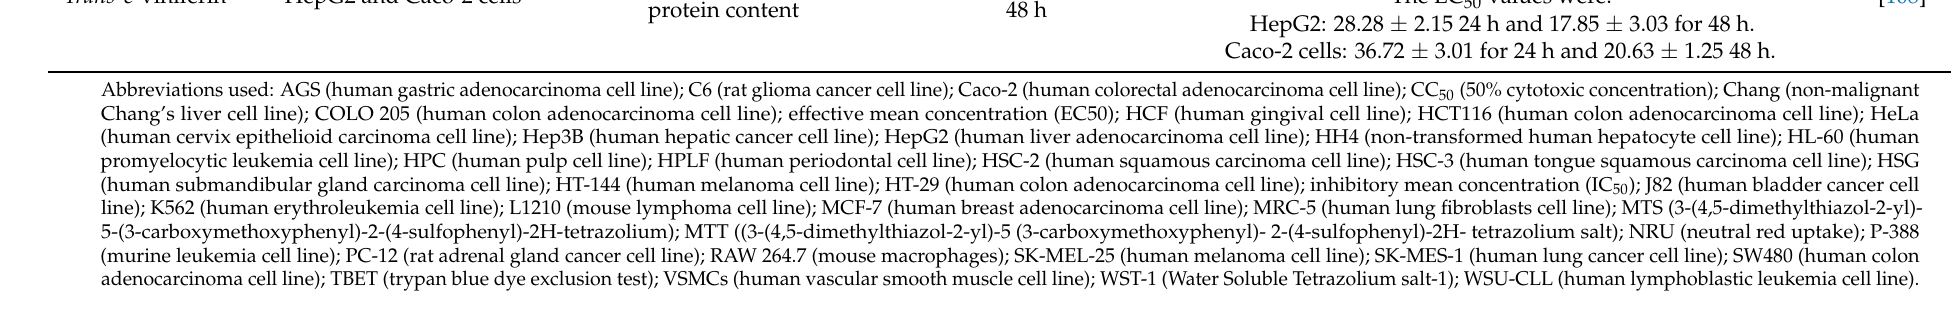
Cell number decreased in a dose- and time-dependent manner, being more cytotoxic in Hep3B cells. In HH4 cells, higher concentrations were needed to induce